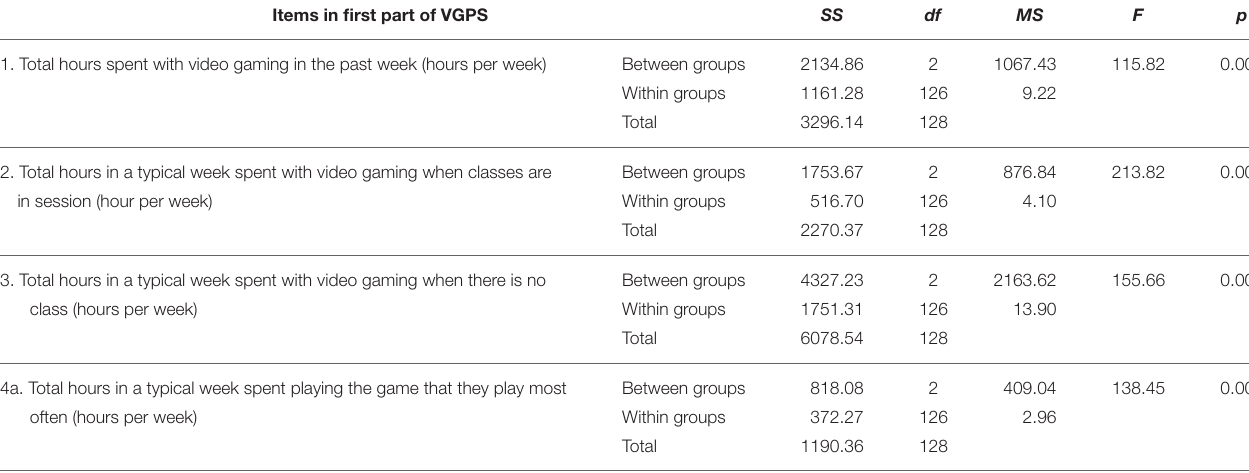
TABLE 4 | Comparison of total hours of video gaming per week by within and between three expertise groups.